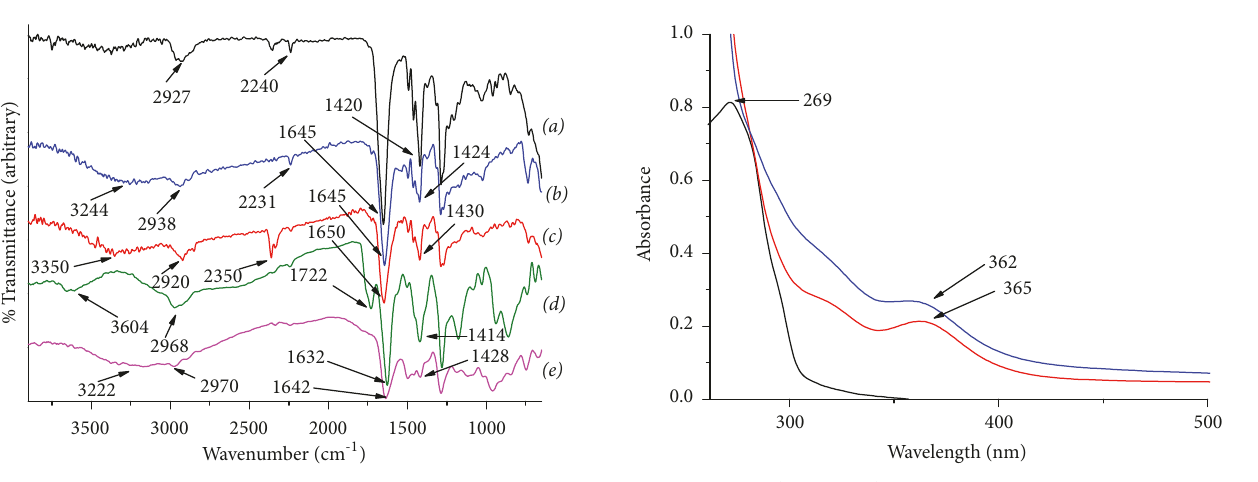
Figure 4: FT-IR spectra of the copolymer and the polyelectrolytes: (a) P(VP-co-AcN); (b) P(VP-co-AcN)-HNO 3 at room temperature;